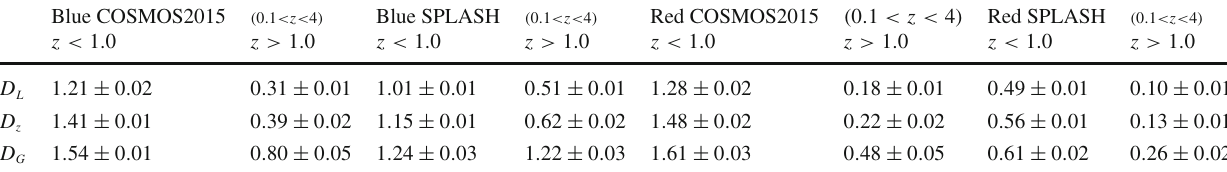
Table6 Fractaldimensionscalculatedintheselectedblue-star-forming and red-quiescent and then volume-limit-filtered galaxy subsamples of the COSMOS2015 and SPLASH redshift surveys in the range z ≤ 4. The single fractal dimensions D L , D z and D G were obtained from the galaxy distributions respectively using the luminosity distance d L , red- shift distance d z and galaxy area distance (transverse comoving dis- tance) d G . The results were calculated considering only H 0 = 70